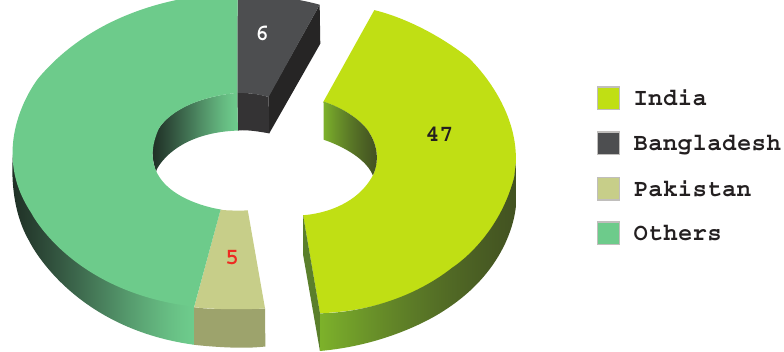
Figure 1. Shows the percent distribution of underweight children in South Asia and the rest of the world. Source: Global disease burden 2010